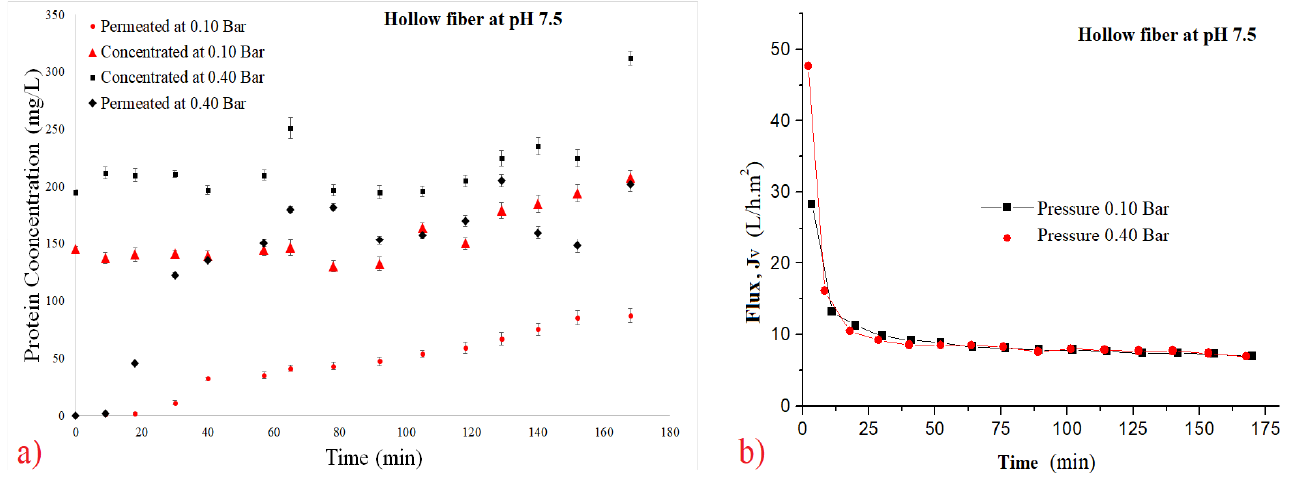
Figure 6. Effect of pressure on filtration flux of the 0.1 µm hollow fiber membrane at pH 7.5. ( a ) Total protein curves and ( b ) flux curves.